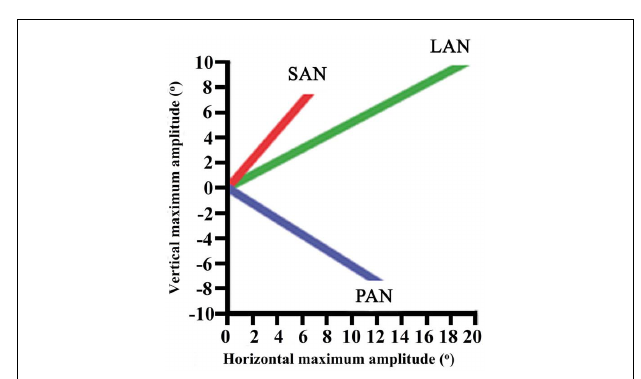
FIGURE 4 | Maximum vertical and horizontal amplitudes of the eye during ampullar nerve stimulation of each